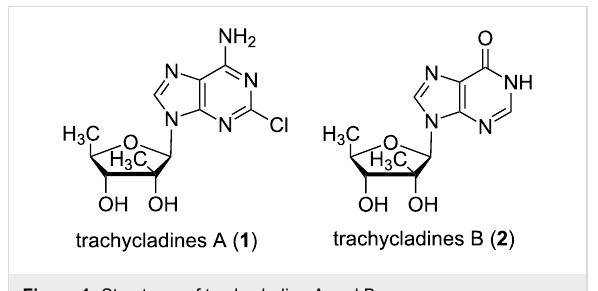
Figure 1: Structures of trachycladine A and B.